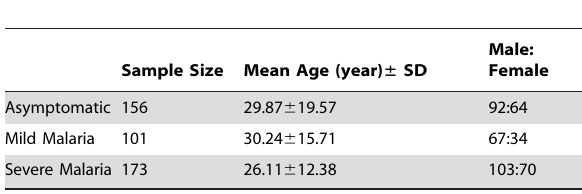
Table 1. Characteristics of studied subjects segregated according to clinical classification.